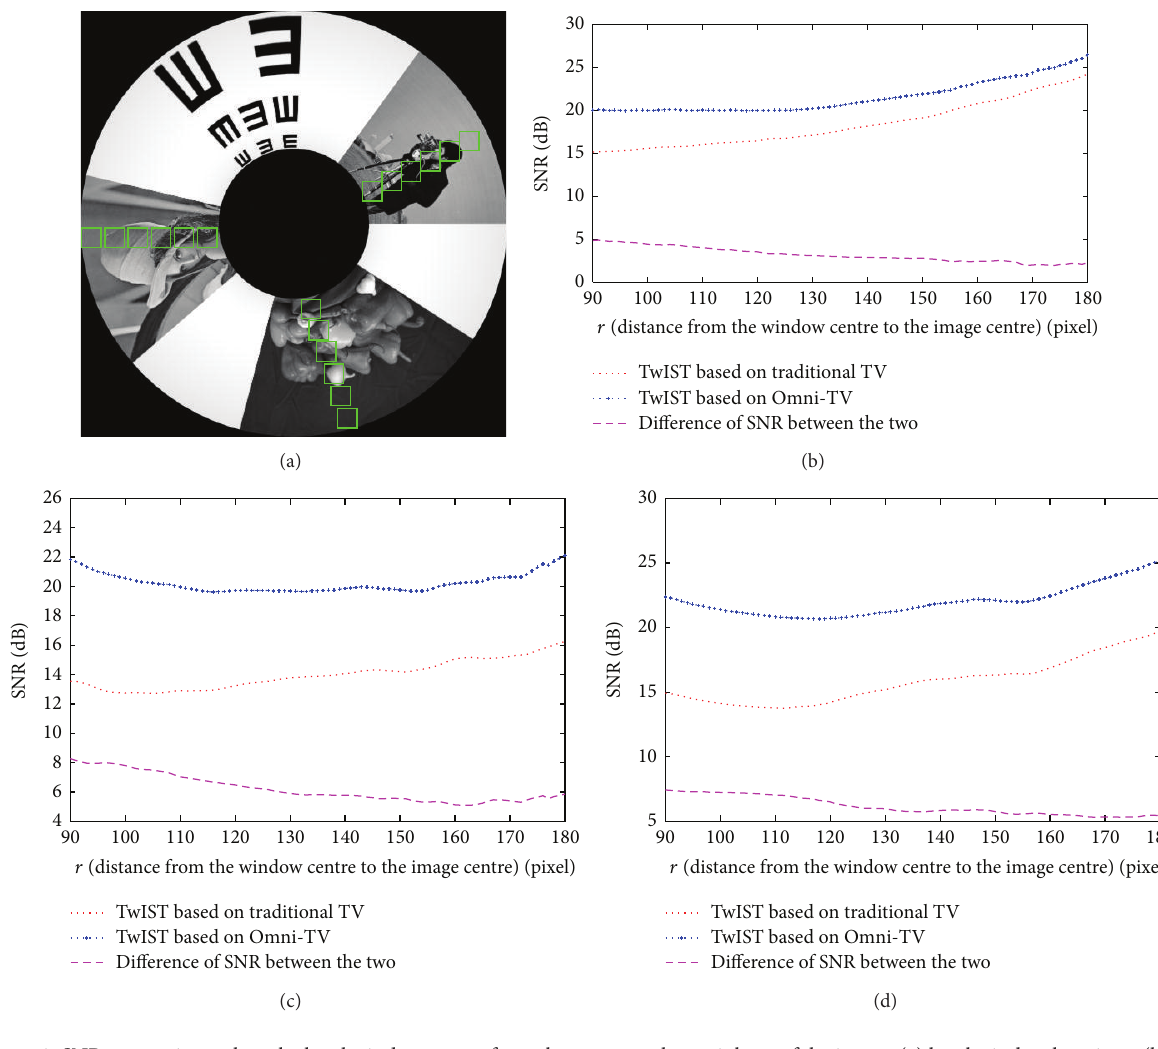
Figure 9: SNR comparison when the local window moves from the centre to the periphery of the image: (a) local window locations; (b) SNR comparison of cameraman; (c) SNR comparison of lena; (d) SNR comparison of